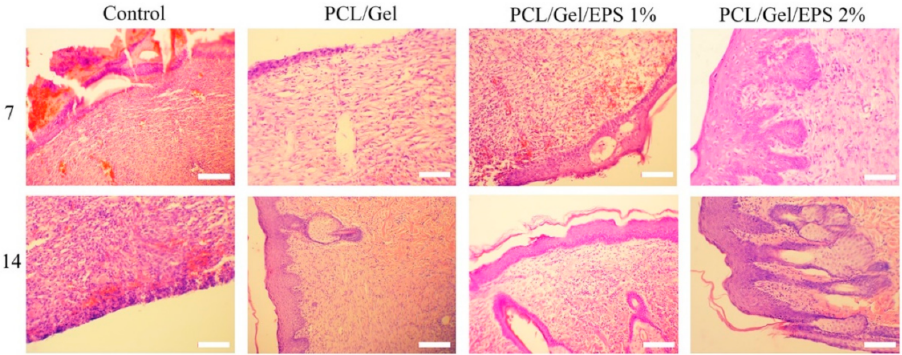
Figure 7. Microscopic images of Hematoxylin and Eosin-stained tissues after 7- and 14-days